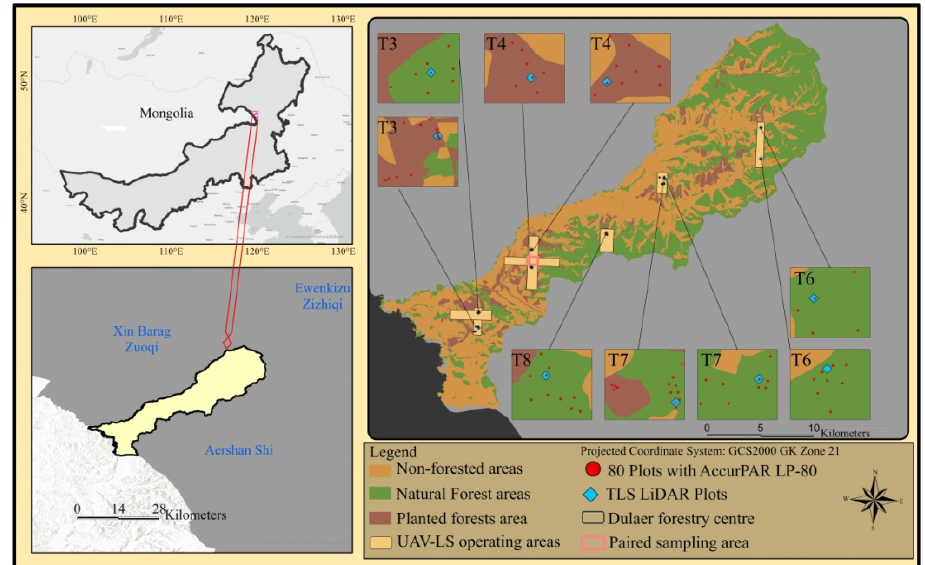
Figure 3 . Location of the study area. T3–T6 in the figure represent the measured sample plots in each UAV-LS transects.